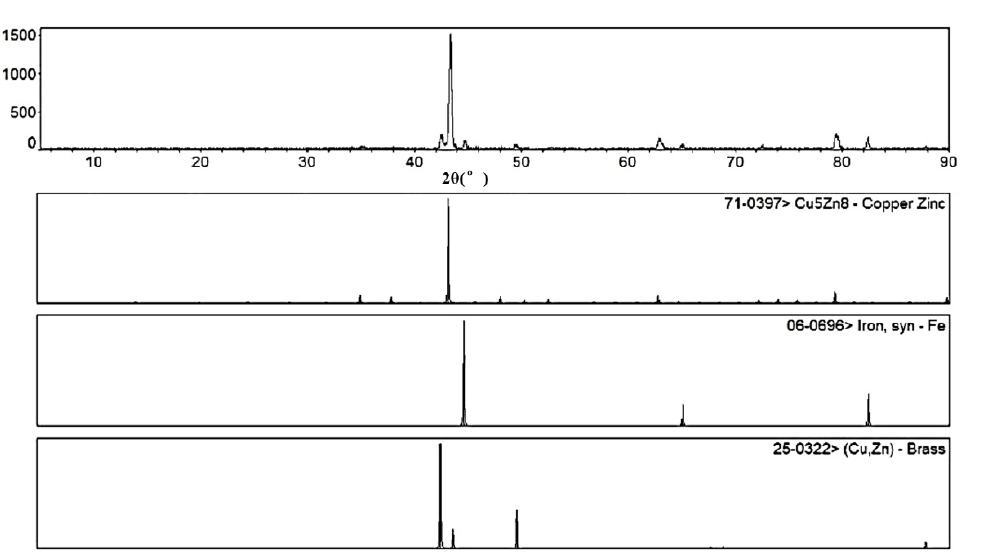
Figure 7. XRD spectrum of the prepared Cu-Zn superhydrophobic surfaces.